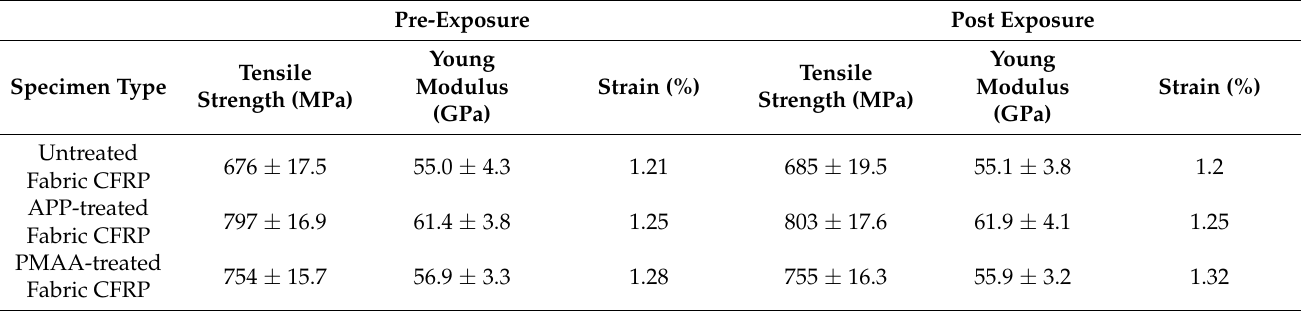
Table 9. Tensile properties of composite materials pre- and post-exposure. (Number of specimens tested: 5). Pre-Exposure Post Exposure Specimen